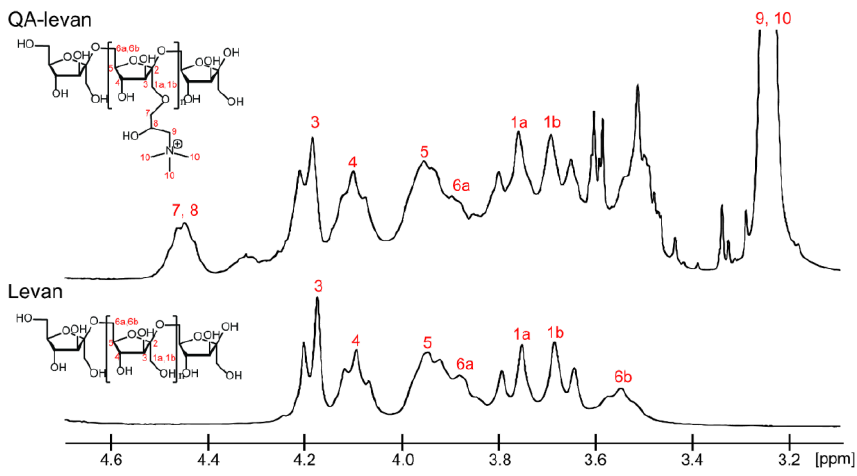
Figure 2. 1 H NMR spectra of levan and QA-levan in D 2 O. Numbers 2 − 6 represented the H group on the fructosyl unit of levan. Numbers 7 − 10 were assigned to represent the proton in GTMAC. The data were analyzed using Bruker TopSpin 4.0 software.